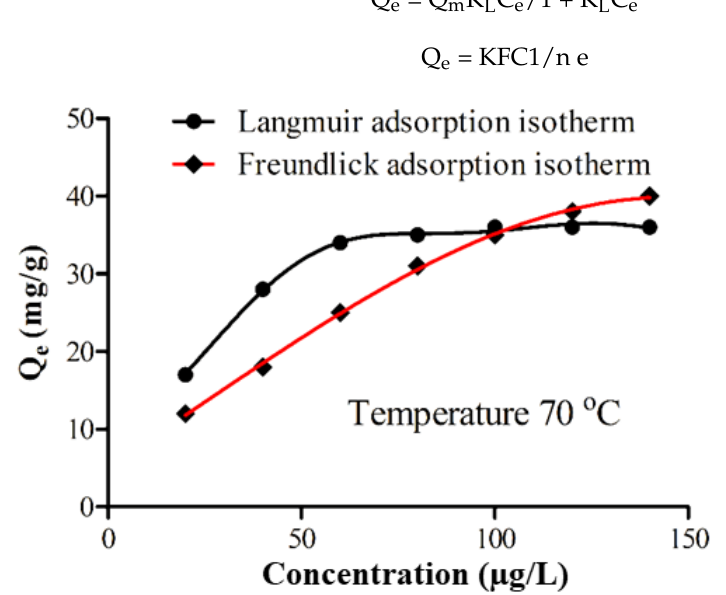
Figure 8. Freundlich and Langmuir isotherms of As(Ш) adsorption on ZnO – CuO/g – C 3 N 4 .